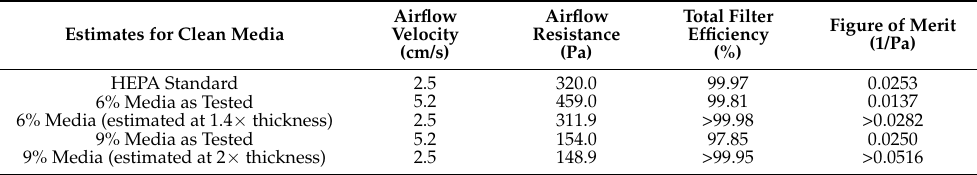
Table 4. Comparison of filtration results to ASME AG-1